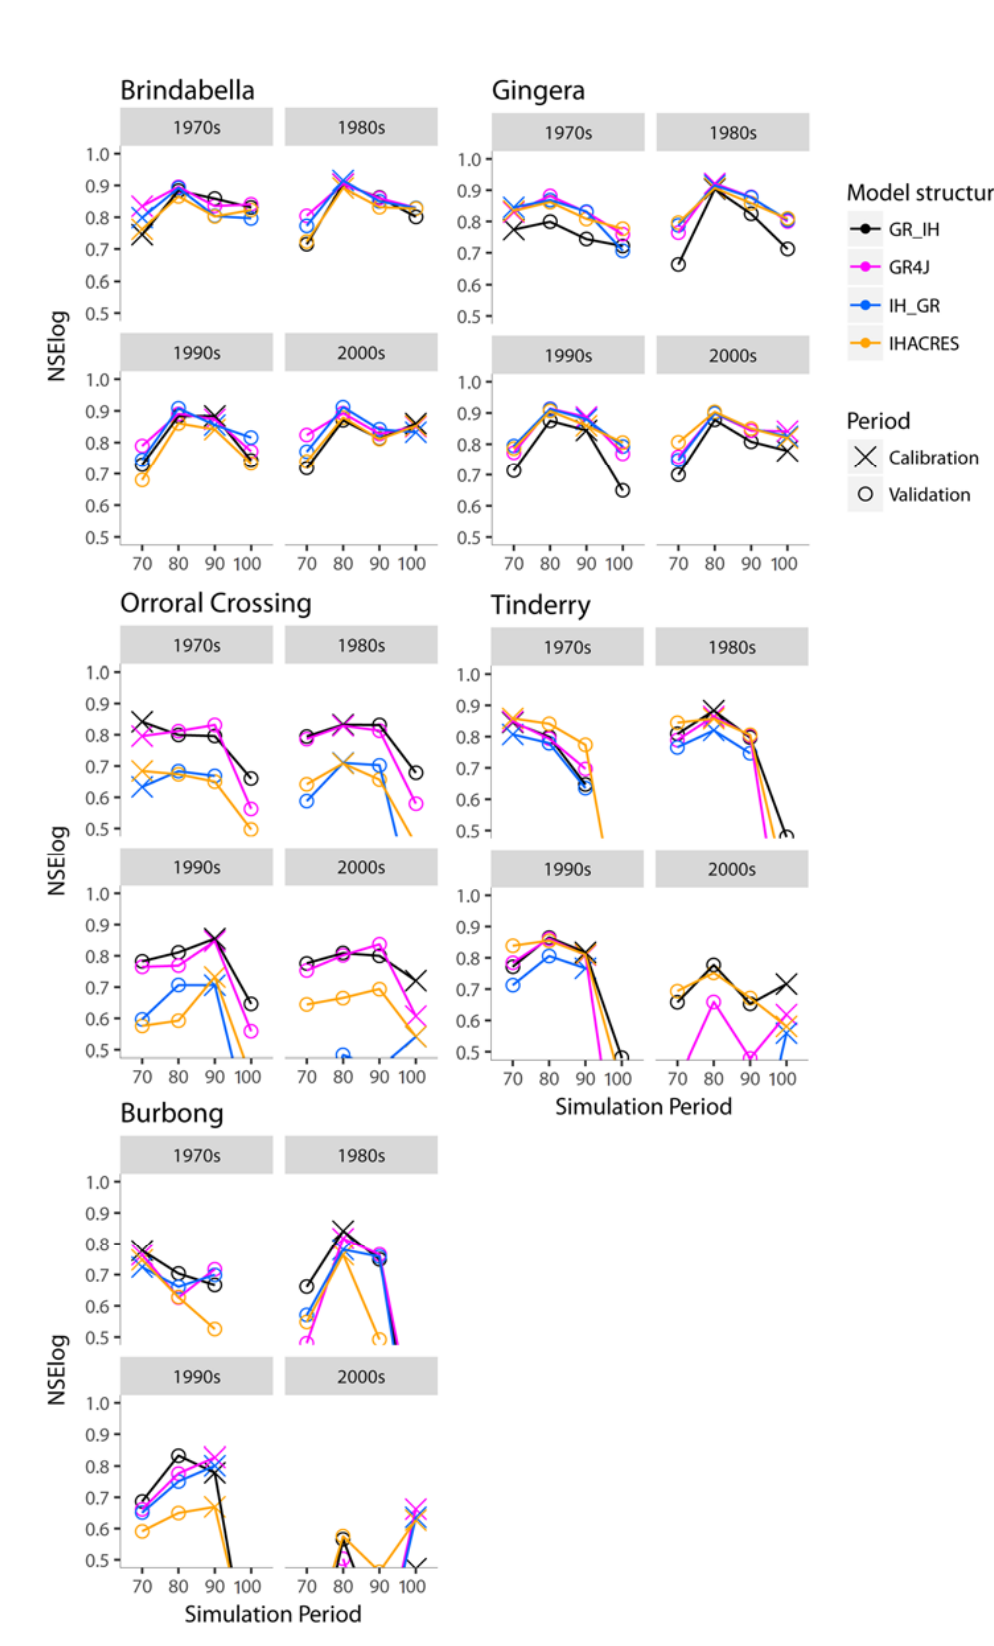
Figure 3. Comparison of the NSElog values of the four rainfall – runoff models for the five catchments: Brindabella (wet), Gingera (wet), Orroral Crossing (intermediate), Tinderry (dry), and Burbong (dry).